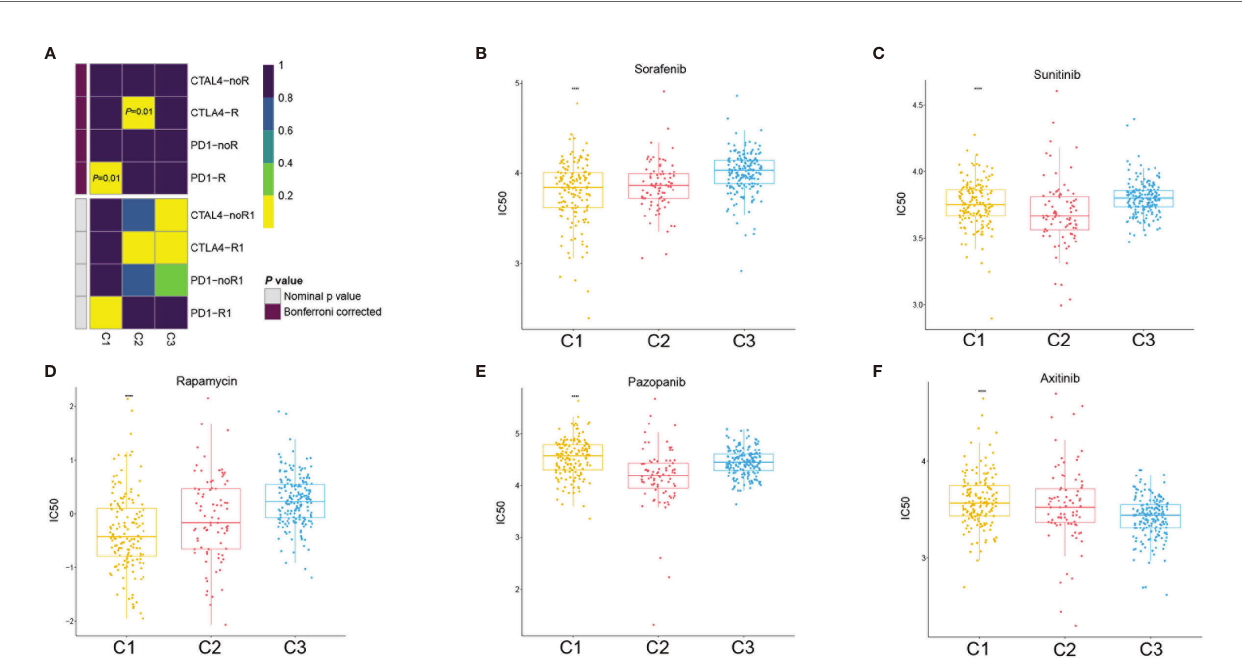
FIGURE 8 | Immunotherapy and target therapy response prediction in the clear cell renal cell carcinoma (ccRCC) subclasses. (A) Response of the three ccRCC subclasses to PD-1 and CTLA-4 immunotherapy. (B – F) Sensitivity of the three ccRCC subclasses to sorafenib (B) , sunitinib (C) , rapamycin (D) , pazopanib (E) , and axitinib (F) . **** p <